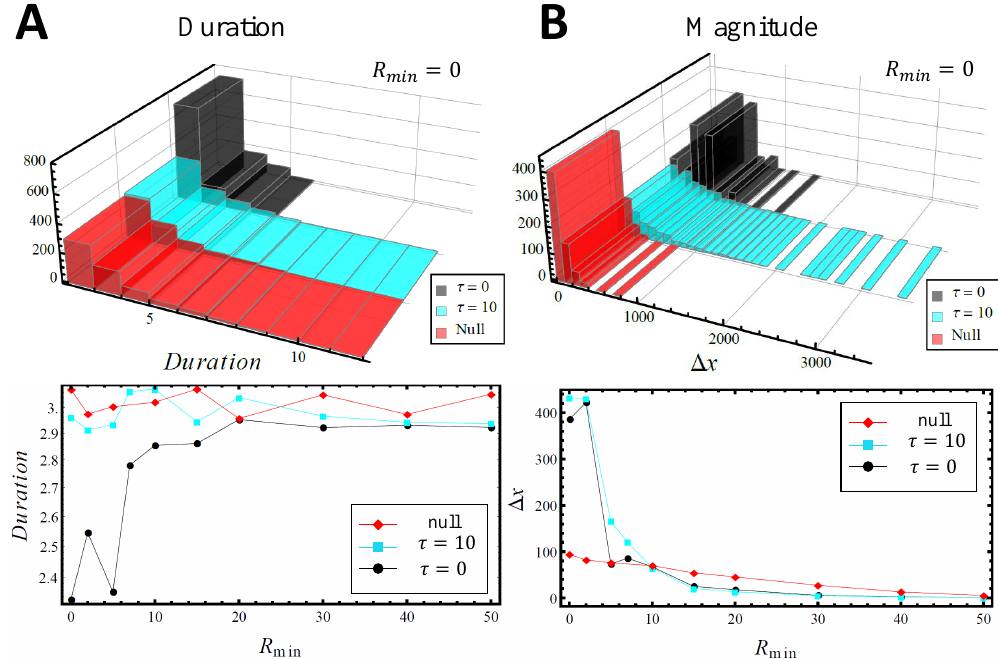
Figure 6. ( A ) Simulation results for fixed-node extreme events in a system of N = 1001 agents with s = 2 strategies per agent and m = 3. The DGCMG corresponds to a delay of τ = 10 timesteps as compared to the GCMG where τ = 0 by definition. The null model (see text) is unchanged by a delay, since it involves memoryless coins for strategies. Upper panel shows the distribution of durations for a given threshold R min , while lower panel shows the mean duration as a function of R min ; ( B ) Analogous to A but for magnitude rather than duration. The magnitude is defined as the price difference before and after the